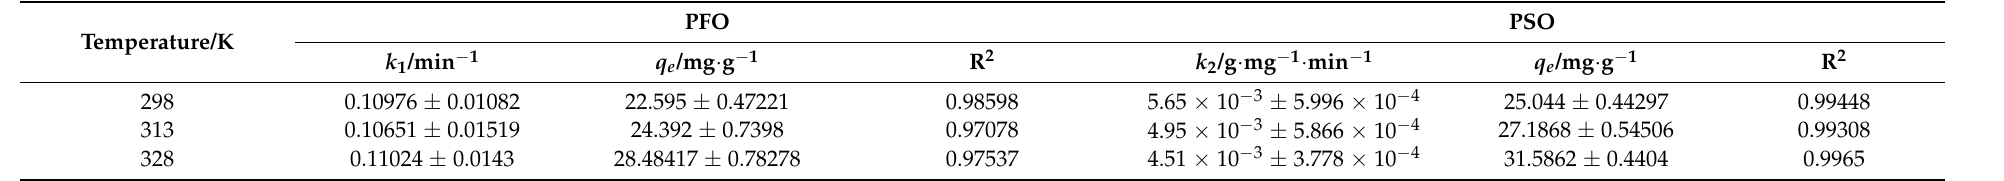
Table 6. Kinetic model fitting constants at different